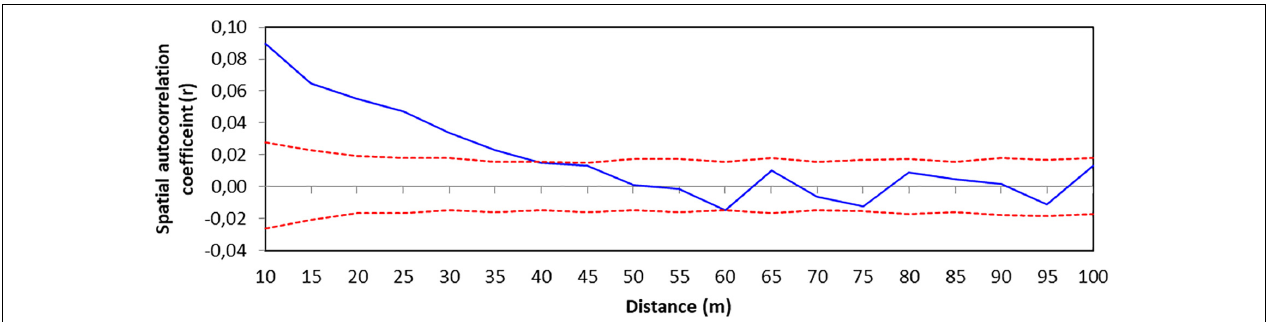
FIGURE 4 | Correlogram showing autocorrelation at 10–100 m distances for all nine northern red oak populations combined. Broken lines represent 95% confidence